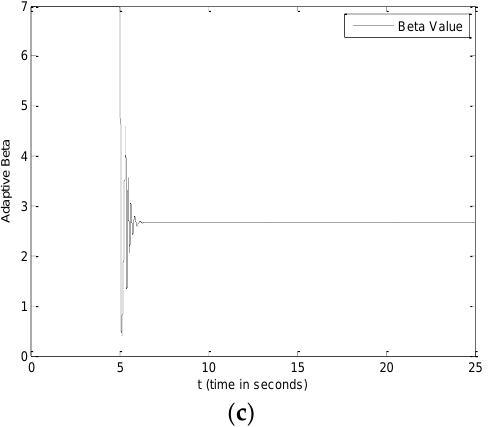
Figure 16. Time-delay anti-synchronization. Fractional order derivative with 𝛼 = 0.9,𝛼 = 0.8,𝛼 = 0.5 and time delay 𝜏 = 5 s. Graphs of (𝐚) 𝜎, (𝐛) 𝜌, (𝐜) 𝛽 values of slave systems.